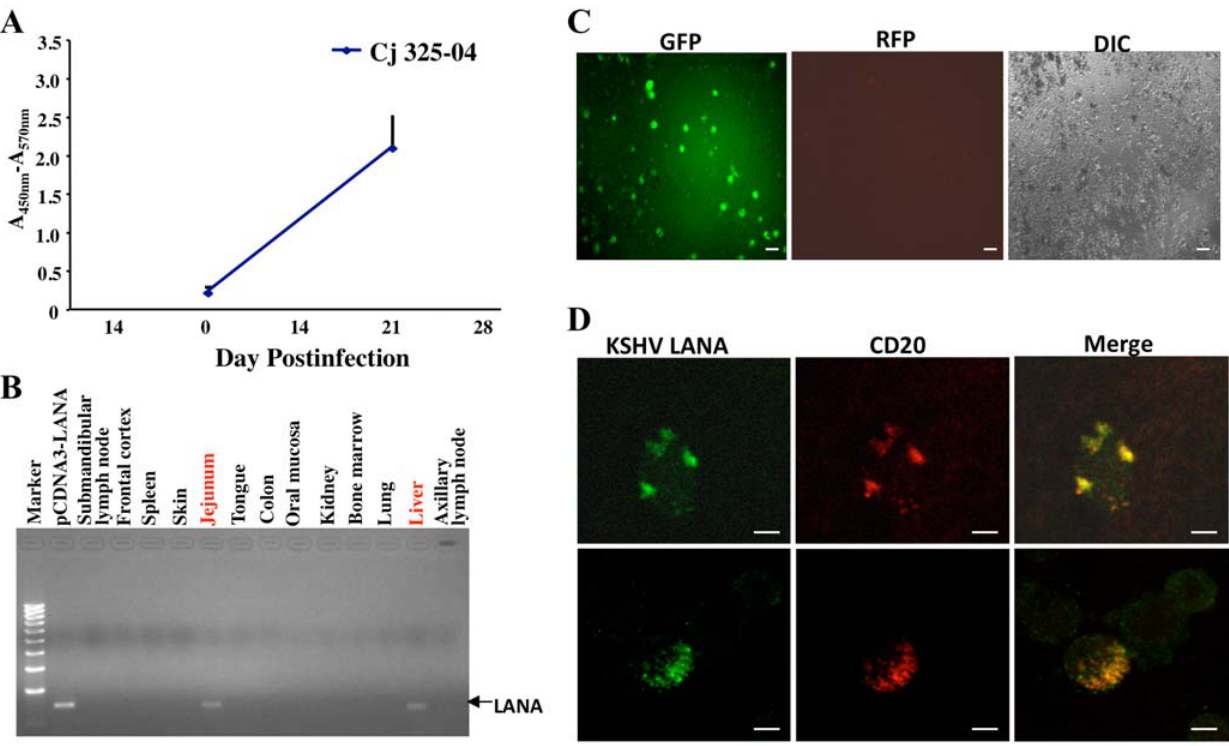
Figure 3. The early infection of rKSHV.219 in common marmoset. ( A ) Anti-KSHV ELISA with sera from Cj325-04 (1:100 dilution) was performed as described in Figure 1A. The results show the averages of two repeats and standard deviations. These assays were reproduced by three independent occasions. ( B ) The PCR products of KSHV DNA from various tissues of infected marmoset Cj325-04 at day 21 P.I. ( C ) Immunofluorescence and differential interference contrast microscopy [34] of PBMCs from Cj325-04 at day 21 P.I. The scale bars represent 30 m m. It should be noted that this picture shows an example of a rare positive field, but not reflecting the overall incidence of GFP-positive cells. ( D ) The PBMCs of the KSHV- infected marmoset (day 21 P.I.) were subjected to immunostaining with anti-KSHV LANA. The pictures presented here are representative of multiple immunofluorescence (top panel) and phase contrast (the bottom panel) images of the PBMCs from Cj325-04 at 21 P.I. The scale bars represent 2 m m.